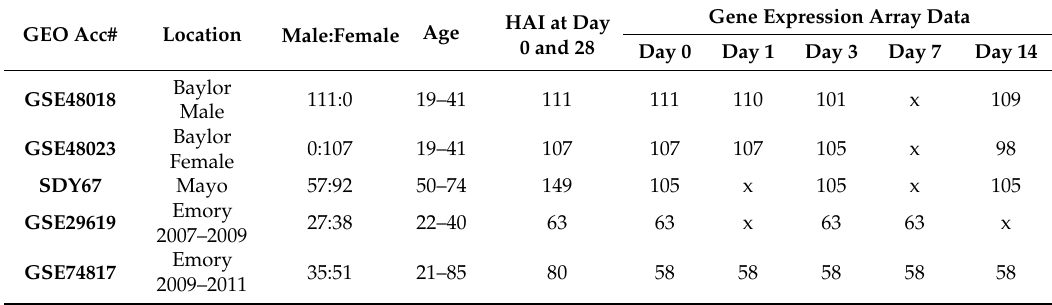
Table 1. Influenza vaccine data used for training and validation. Demographic summary and number of subjects with available